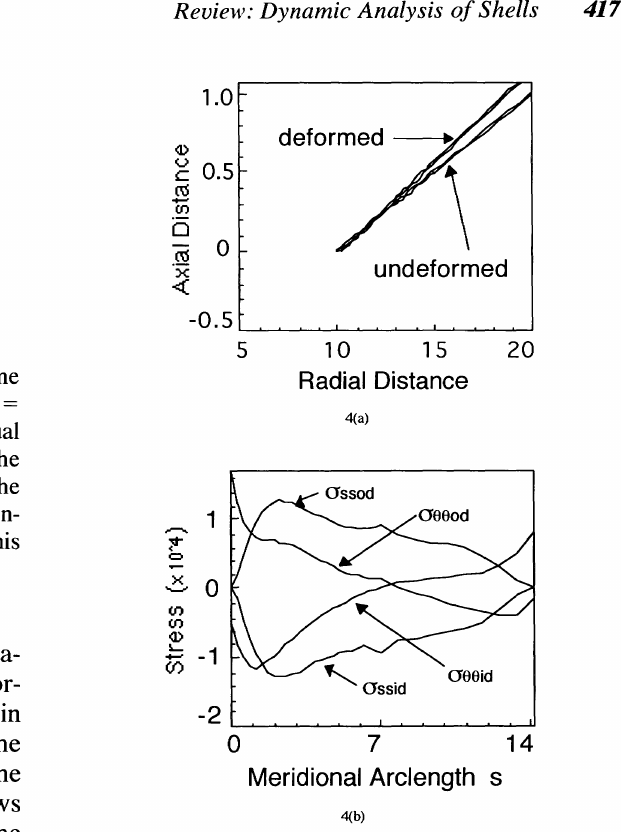
FIGURE 4 Conical shell 45° with free ends with a ring load at the center, oscillating at a frequency 1 = 5 Hz, near the inextensional ring frequency ofthe larger endII = 3.4 Hz (n = 2,1£ = 438 Hz, R/t = 200). More than for the cylinder in Fig. 2, no effect of the localized load is seen in the deformation (a) and only a little in the stress (b). A computation with a course mesh can easily capture this behavior.